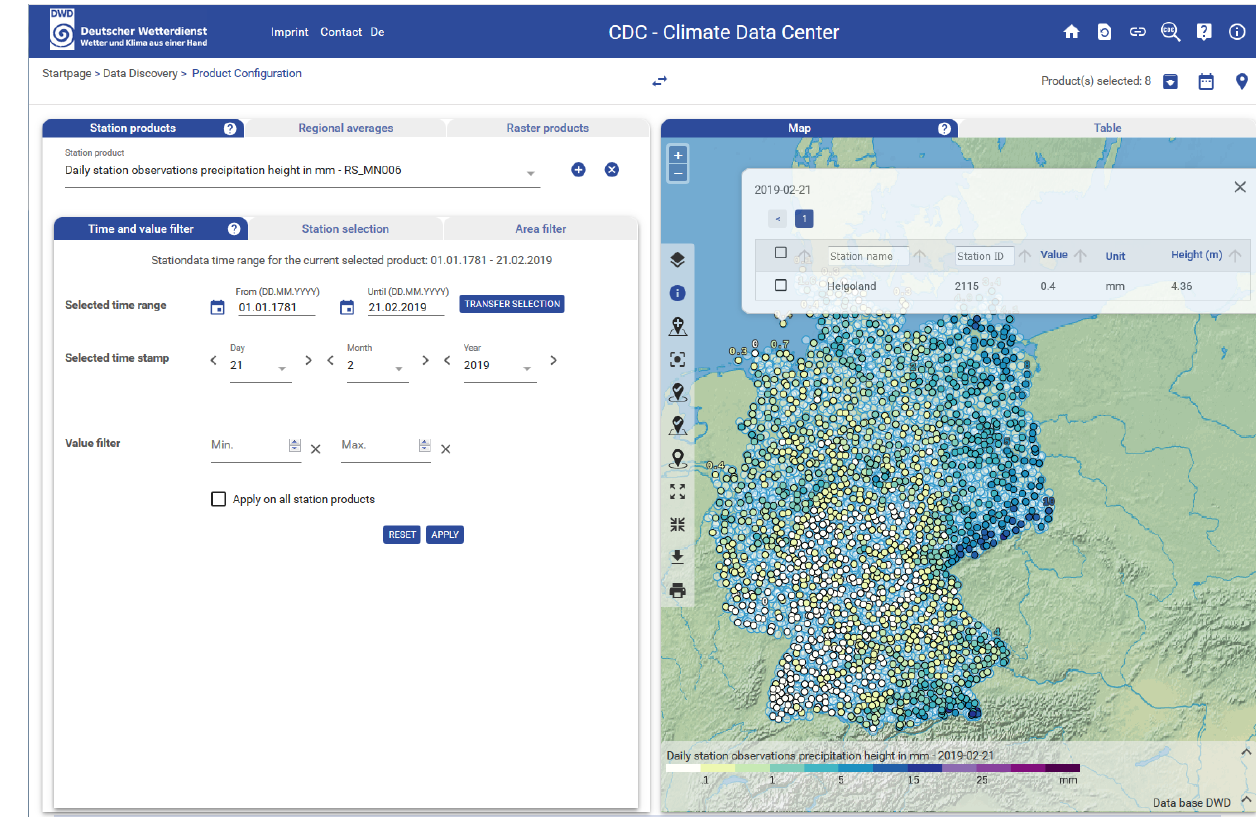
Figure 5. Interactive component with one station selected in the map display area (Source: Deutscher Wetterdienst).